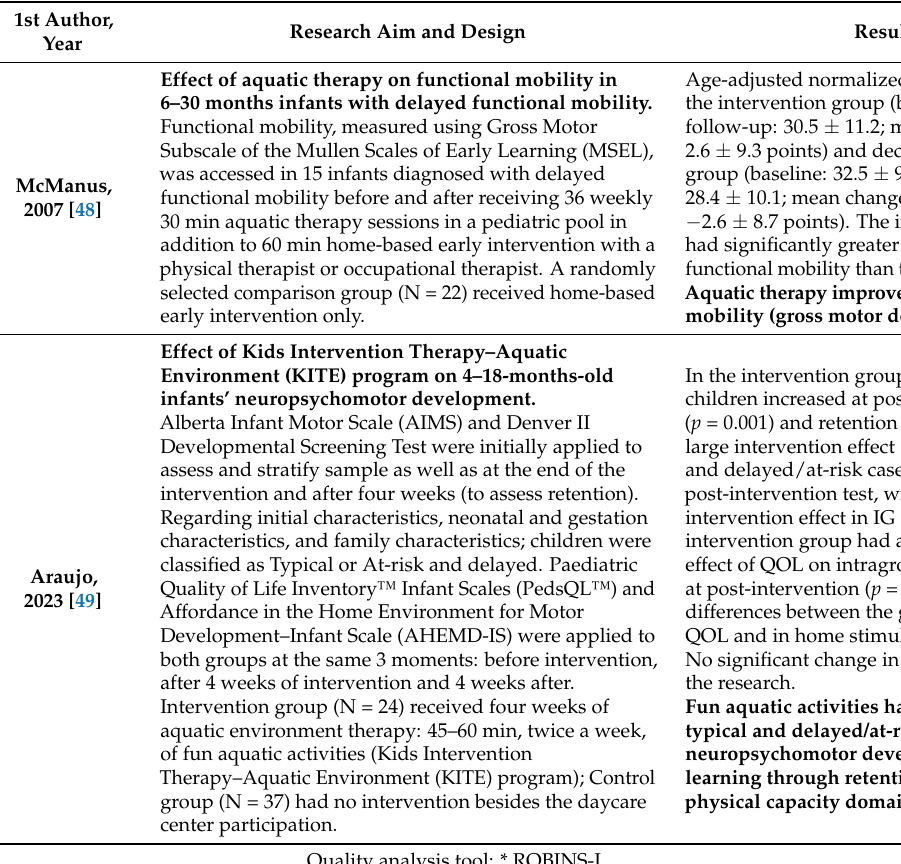
Table 5. Effects of exposure to baby aquatic therapy programs on infants’